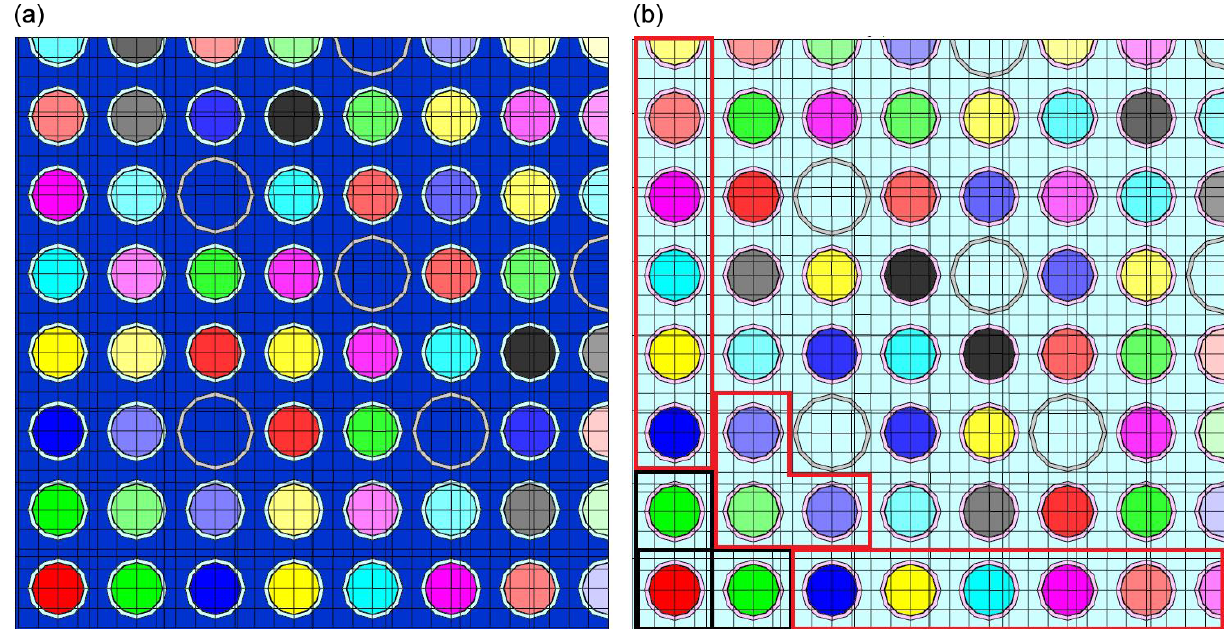
Fig. 1. UO 2 (left) and MOX (right) KKG 1/4 assembly fuel model in